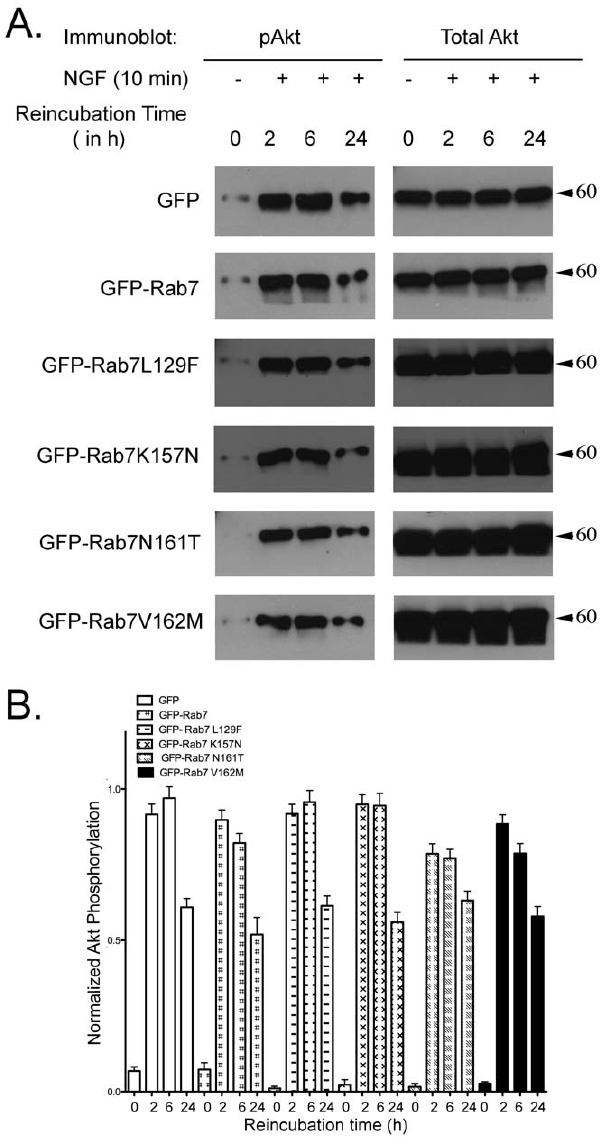
Figure 4. Cells Expressing Rab7 CMT2B Mutants Have no Effect on Akt Signaling. (A) Transiently transfected PC12 cells expressing GFP, GFP-Rab7wt, GFP-Rab7L129F, GFP-Rab7K157N, GFP-Rab7N161T, GFP-Rab7 V162M were briefly stimulated with NGF (200 ng/ml) followed by surface stripping of ligand and reincubation in 0.1% BSA- DMEM for 2–24 h. Subsequently, cells were lysed and equal amounts of protein were immunoblotted and probed for total and phosphorylated Akt. (B) Films from three independent experiments were quantified by Image J analysis. Bar graph shows levels of pAkt in GFP-Rab7wt and CMT2B mutant expressing cells. In each case the amount of pAkt was normalized to the amount of GFP protein expressed. The bar graph shows the fold-change in pAkt as a function of pAkt in the GFP only control at each respective time point. Error bars indicating mean 6 S.E.M. n=3, p values were not significant, indicating no differences between samples.